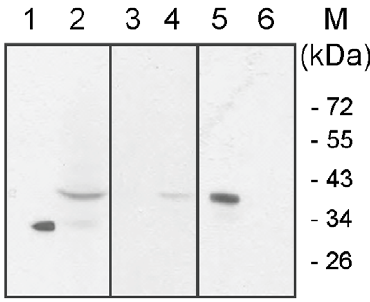
Figure 6. Detection of pH-dependent FcRn binding of IgG in rabbit yolk sac samples. In this assay we analyzed the pH dependent binding of the lysate of rabbit yolk sac of 24 days post coitum (dpc) embryos at pH 6.0 and pH 7.4 to rabbit IgG that was coupled to a Sepharose matrix. Absorbed proteins were then eluated from the matrix and the presence of the FcRn was Western blot tested in these samples as well as in the unbound fractions. The eluted samples contain FcRn only if binding occurred at pH 6 but not at pH 7.4 (bands 5 and 6, respectively). Confirming this result, we could not detect FcRn in the unbound fraction when binding occurred at pH 6.0 (i.e. all FcRn molecule bound to matrix) but FcRn remained in the unbound fraction when the pH of reaction media was neutral (i.e. at this pH no FcRn bound to the IgG-matrix) (bands 3 and 4, respectively). Recombinant bovine FcRn [46] and rabbit yolk sac protein extract were used as positive controls (bands 1 and 2, respectively).